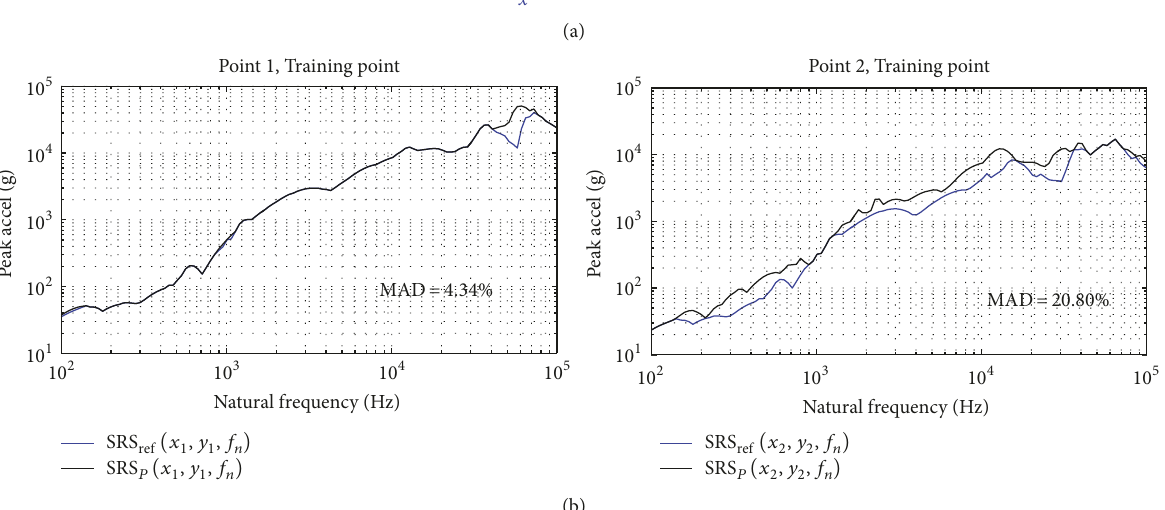
Figure 12: SRS reconstruction on the training points. (a) CFRP specimen. (b) Reconstruction results.